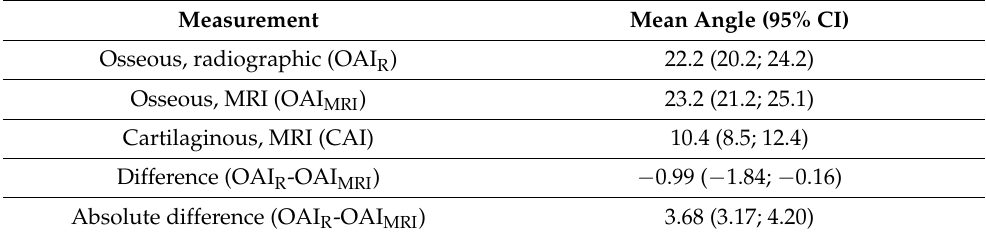
Table 2. Mean values, differences, and absolute differences (angle) of bilateral acetabular index measurements made in the first round of rating by all raters. OAI = osseous acetabular index, CAI = cartilaginous acetabular index.